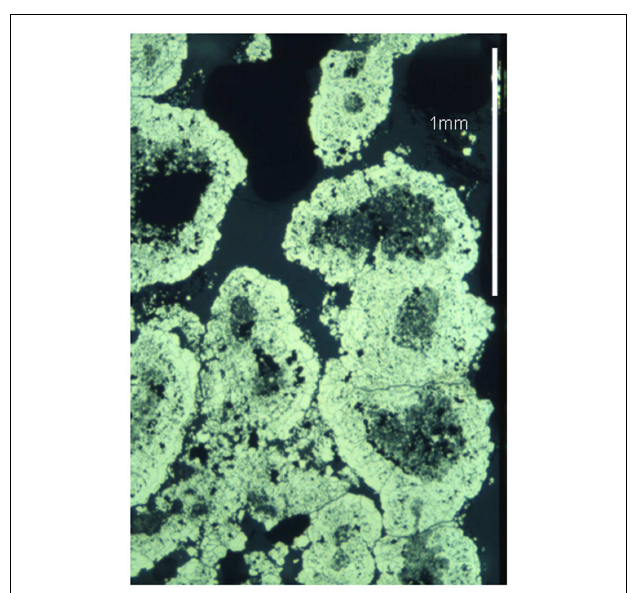
FIGURE 6 |The hydrothermal mound as an acetate and methane generator. Steep physicochemical gradients are focused at the margin of FIGURE 7 | Framboids in chimney: Sheaf system, formed from the mound.The inset (cross section of the surface) illustrates the sites coalescing rods of anastamosing microcrystalline pyrite. Black areas (in where anionic organic molecules are produced, constrained, react, and reflected ore microscopy of transverse section) are empty spaces; central automatically organize to emerge as protolife (from Russell and Martin, regions are framboidal pyrite with an exterior of crystalline pyrite (picture by 2004; Russell and Hall, 2006, with kind permission). Compartmental pore Dr. Adrian Boyce reproduced with his kind permission; source: Boyce et al., space may have been partially filled with rapidly precipitated dendrites.The 1983; Boyce, 1990; see Mitra-Delmotte and Mitra, walls to the pores comprised nanocrystals of iron compounds, chiefly of FeS (Wolthers et al., 2003) but including greigite, vivianite, and green rust occupying a silicate matrix.Tapping the ambient protonmotive force the pores and bubbles acted as catalytic culture chambers for organic synthesis, open to H 2 , NH 3 , CH − at their base, selectively permeable and 3 semi-conducting at their upper surface.The font size of the chemical symbols gives a qualitative indication of the concentration of the reactants.